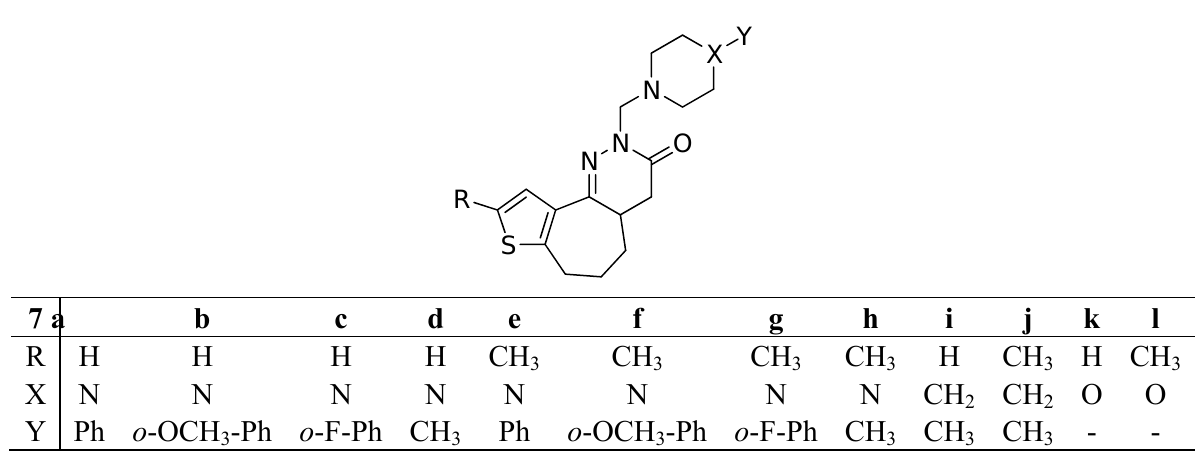
Table 1. Novel thienocyclohepta[1,2- c ]pyridazinones 7a-l .